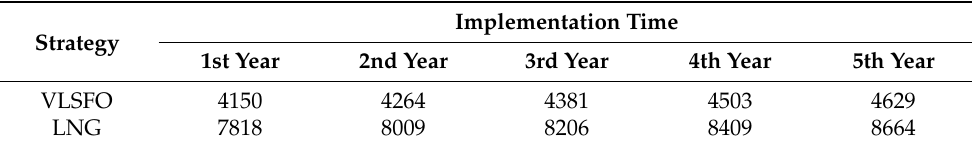
Table 15. Total pollutant emission reductions of the VLSFO and LNG strategies over a five-year period. Unit: tons.